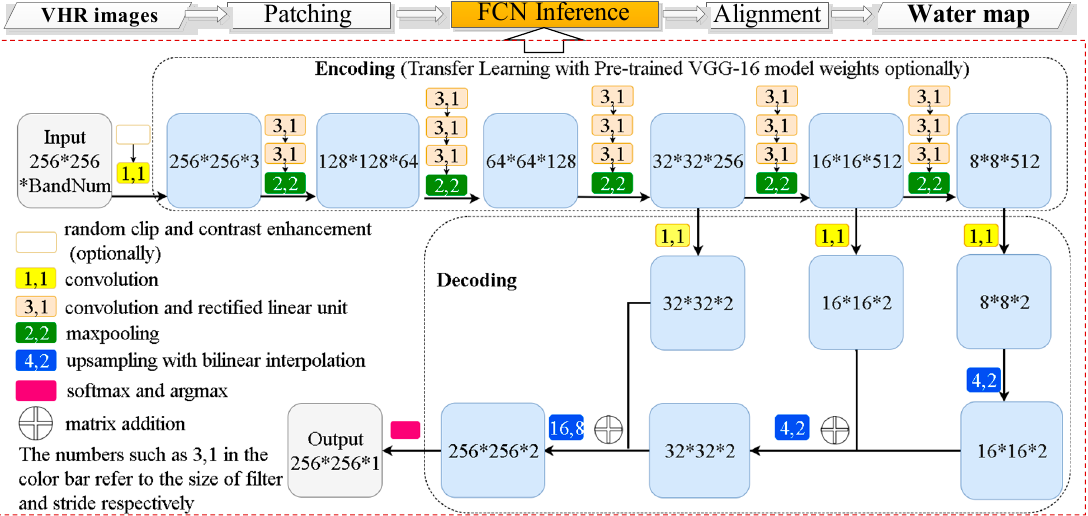
Figure 3. Illustration of the strategy to alleviate the possible boundary e ff ect caused by spatial alignment in the final